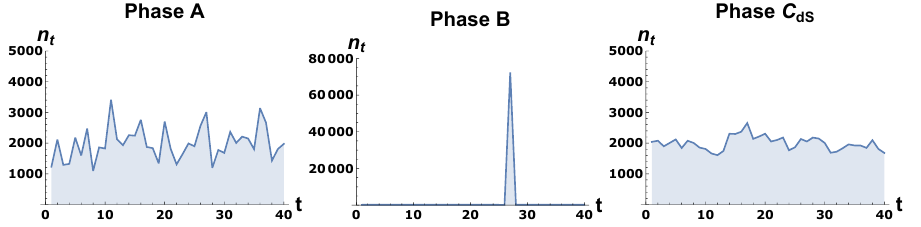
Figure 4. Typical volume profiles n t = N ( 4,1 ) ( t ) in various CDT phases with toroidal spatial topology Σ = T 3 . The volume profile in the C Σ = S 3 b phase is similar to the profile for